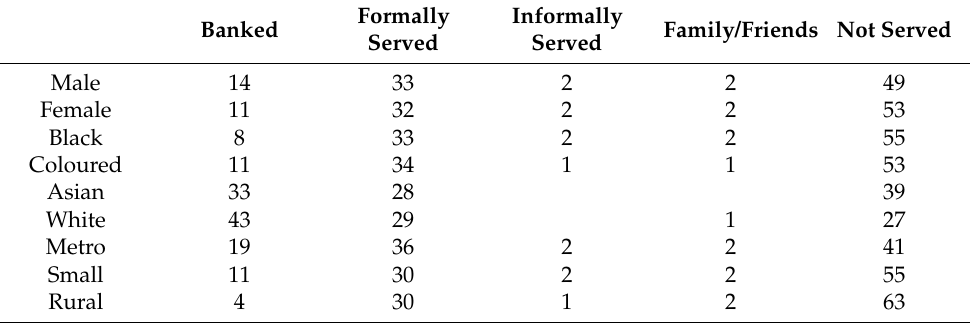
Table 2. Borrowing by demographics 2016.